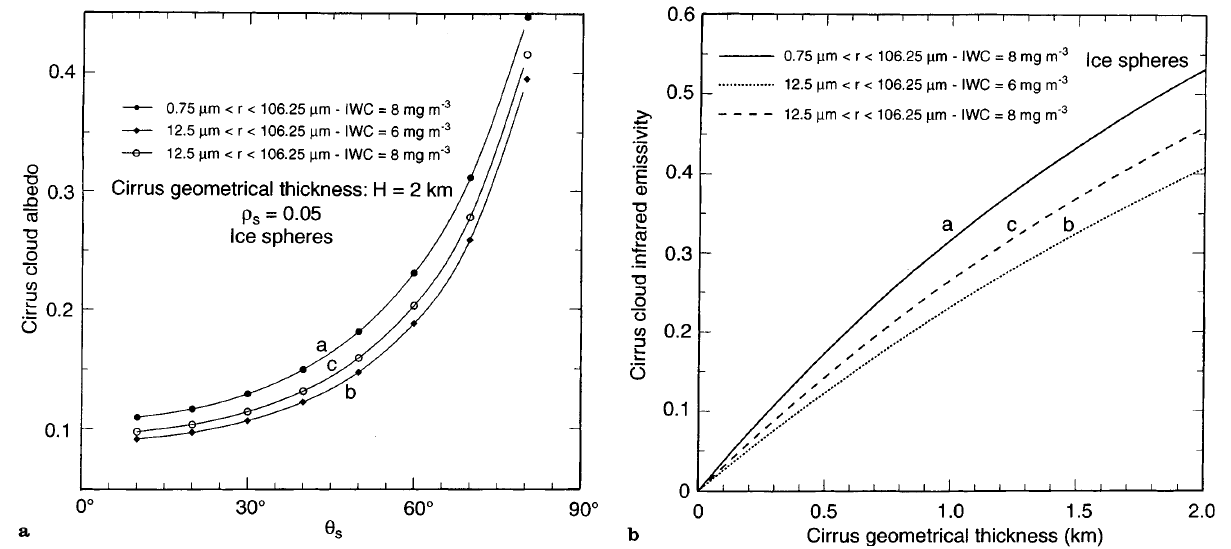
to the truncated size distribution from 12.5 mm which is weighted in order to have the same IWC (8 mg m ) 3 ) as the size distribution = 0.05. The s including the small particles. b Calculated cloud infra-red emissivity as a function of the geometrical thickness for the three particle distributions considered in